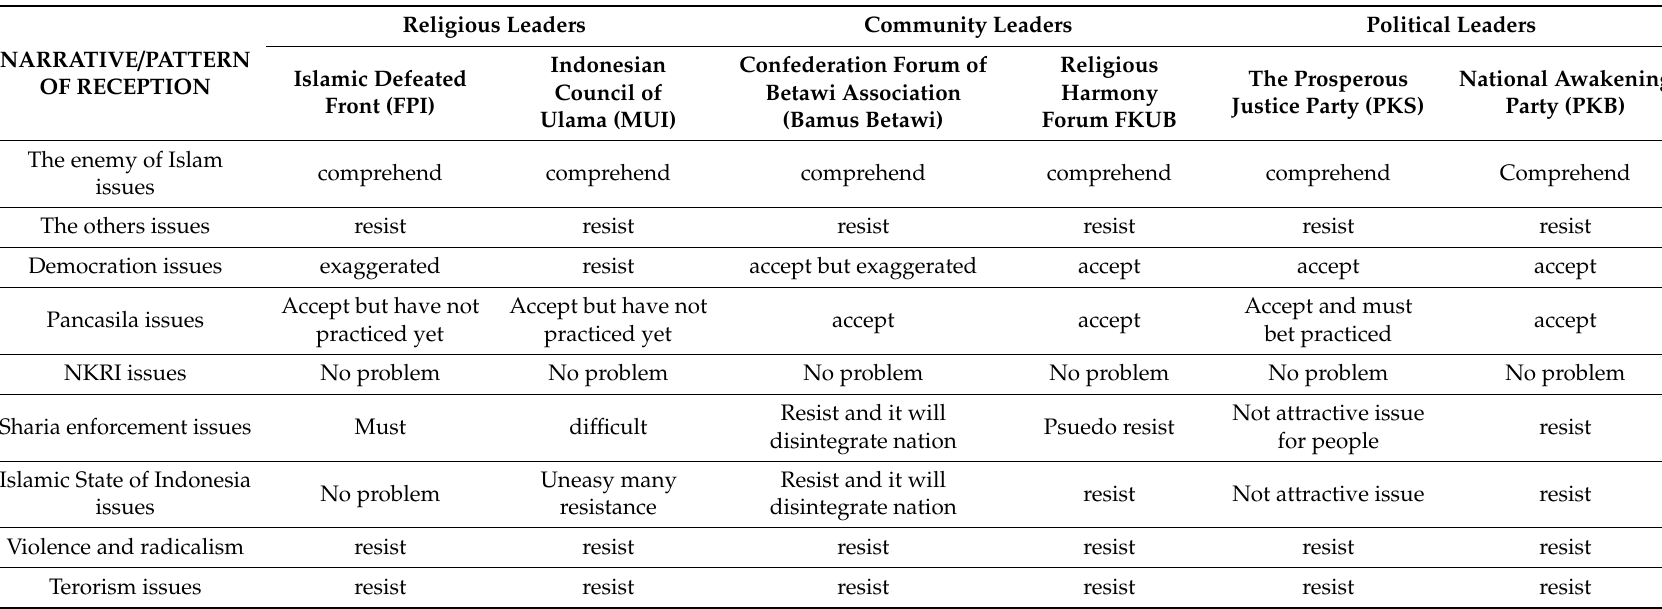
Table 3. Reception Pattern of Radicalism and Terrorism Narrative in Jakarta Metropolitant: Study of Religious Leaders, Community Leaders and Political Leaders